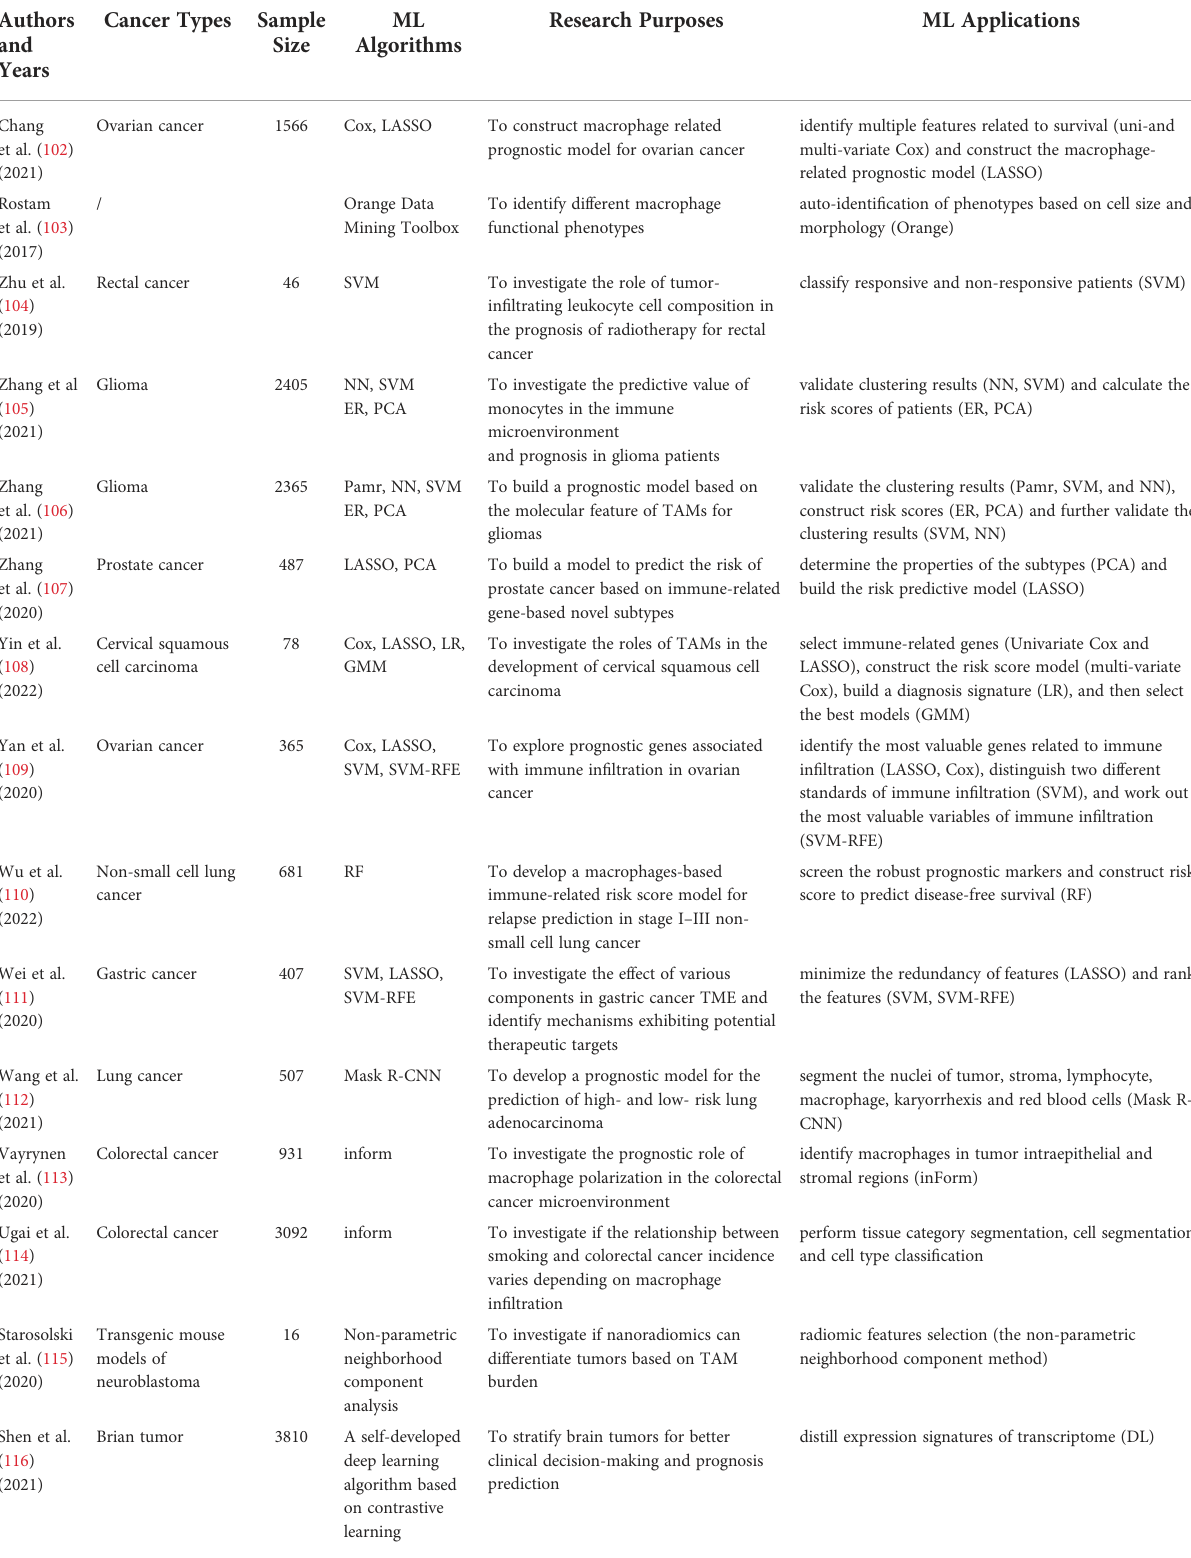
TABLE 5 ML algorithms and their applications in